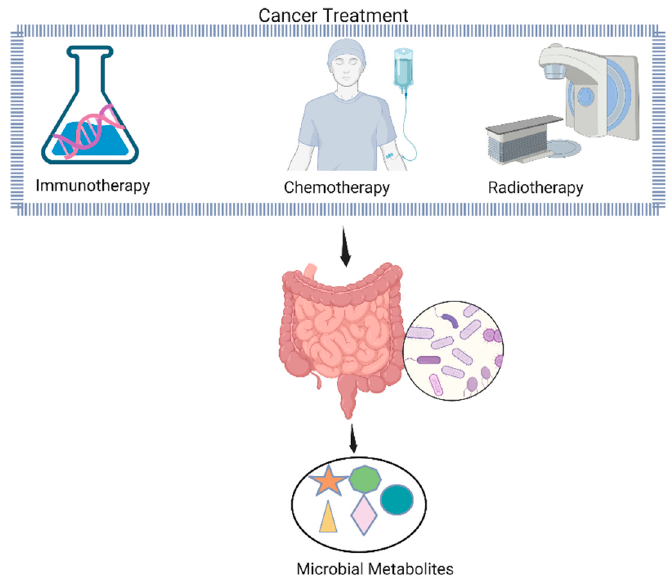
Figure 3. Metabolites produced by the gut microbiota have a key role in controlling the activity of intestinal cells, as well as local and systemic immunological and inflammatory responses. The most effective method for dealing with gut microbiota-derived metabolites and their widespread impacts in order to enhance cancer therapy outcomes will need to be determined. Different colors in circle represent different gut microbes, whereas, different shapes in oval form represent individual metabolite, e.g., star shape for metabolite A, triangle for metabolite B, etc. (This Schematic representation was created using Biorender (h tt ps://biorender.com/)).